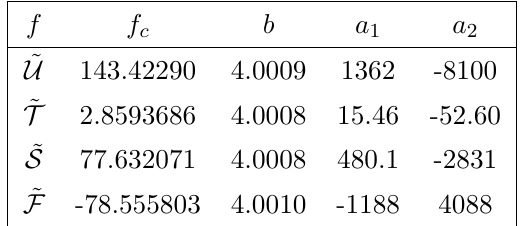
Table 2 . Fit parameters for the function f ( Q ) = f c physical quantities and Q = L A =L . The (cid:12)t parameters were determined using all data points with Q . 0 :